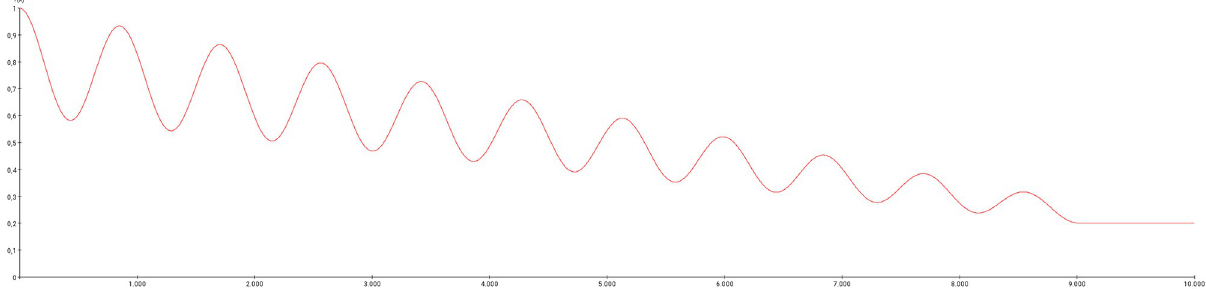
Fig 20. Weight modulation function. The weight modulation function (damped cosine function) is applied to the GM RD-system. Initial conditions V 0 = 1 and W 0 = 1 were set for the dorsal root ganglia of the left side. The number of iterations is 10000. The amplitudes were fixed to 10 and the lower value of the weight reduction was set to